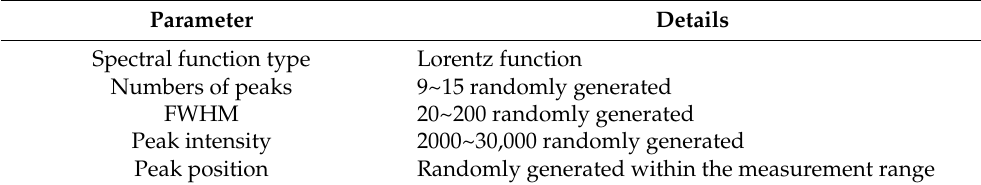
Table 1. Details of the first synthetic Raman spectrum